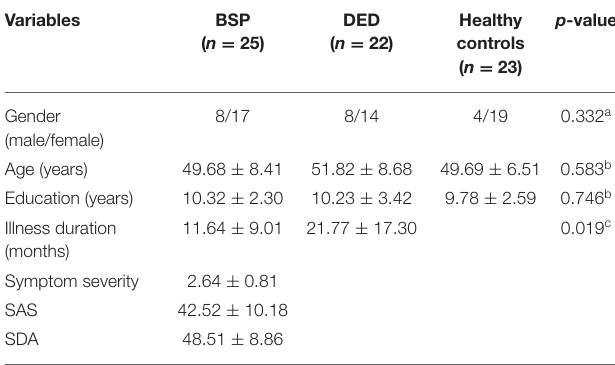
TABLE 1 | Demographic information and clinical profile of the